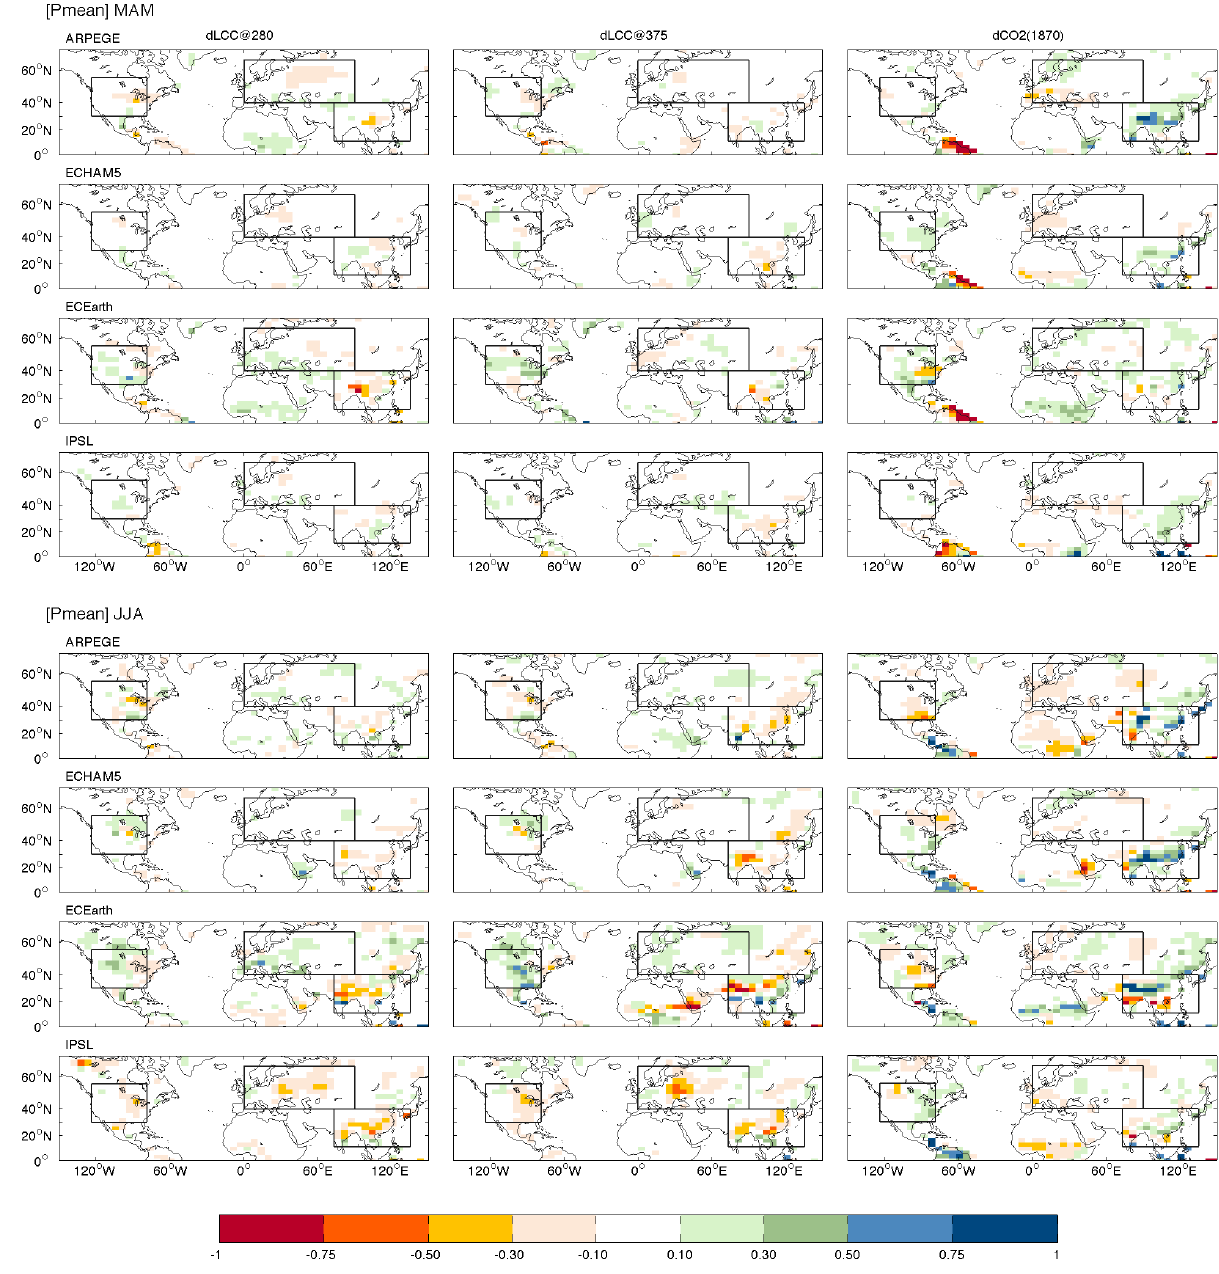
Fig. 3. As Fig. 2 but for mean precipitation (mmday − 1